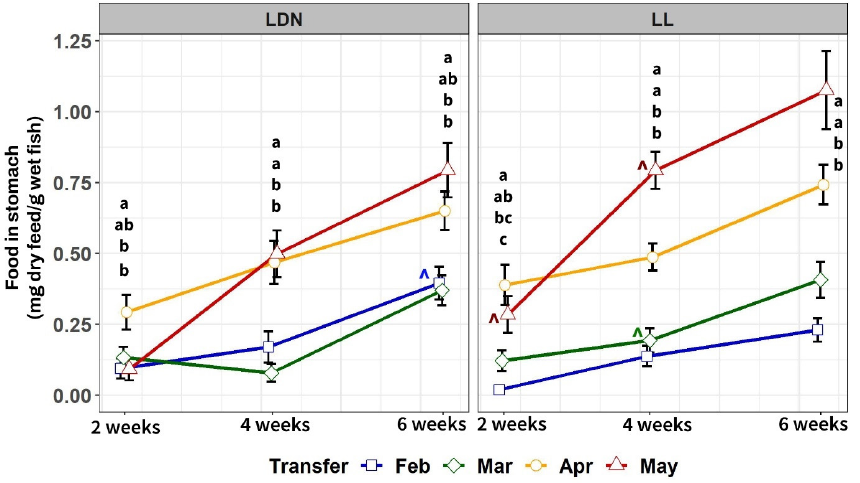
Figure 7. Food in stomach (mg of dry feed per gram of wet fish) after 2, 4, and 6 weeks in seawater, in groups of fish transferred to seawater in different months and reared under LDN or LL photoperiods. Letters “a”, “b”, and “c” indicate significant differences (Tukey post hoc test, p < 0.05) at a given sampling between groups transferred to seawater at different months within a photoperiod regime. Colored signs “ˆ” indicate significant differences (three-way nested ANOVA, p < 0.05) between groups transferred at the same time but that experienced different photoperiods and are located next to the largest of the pair in the color of the transfer